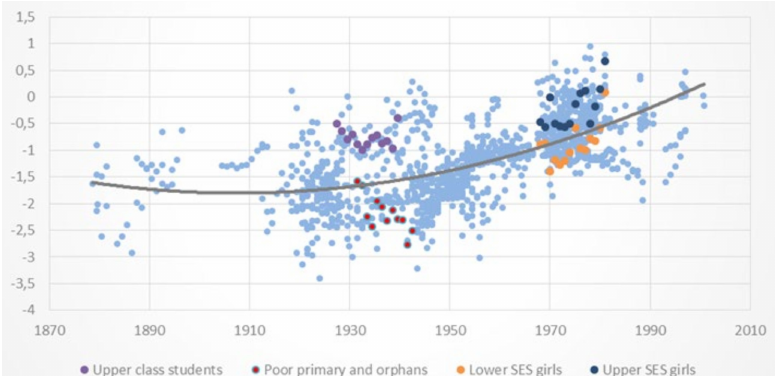
Figure 3. Height-for-Age Z scores (HAZ) of samples of Chilean boys and girls by birth cohorts (1877 − 2001). The four selected samples of girls of upper (two) and lower (two) socioeconomic status described in Table 1 are highlighted against the background of the full dataset.